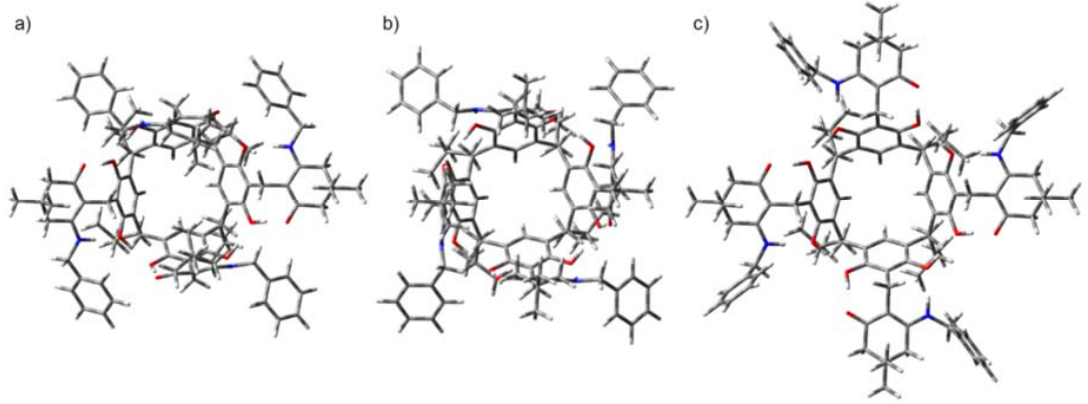
Figure 5. Conformations of 4 optimized by DFT/B3LYP: ( a ) in ‐ out ( C 2 ), ( b ) all ‐ in ( C 4 ), ( c ) all ‐ out ( C 4 ).